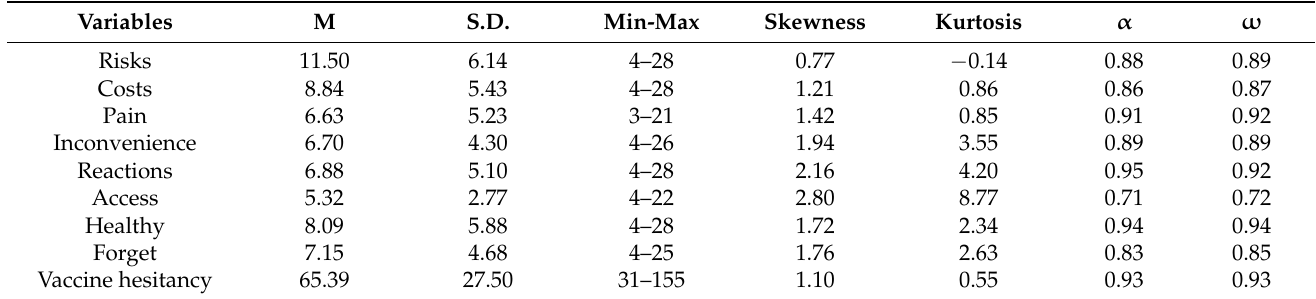
Table 5. The descriptive analysis (mean, S.D., skewness, kurtosis, consistency